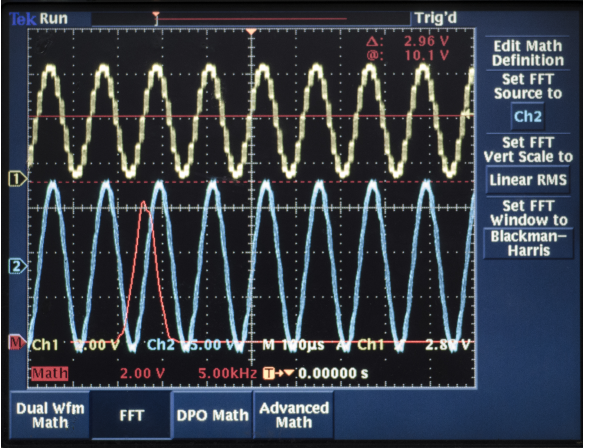
Figure 24. The output of the driving